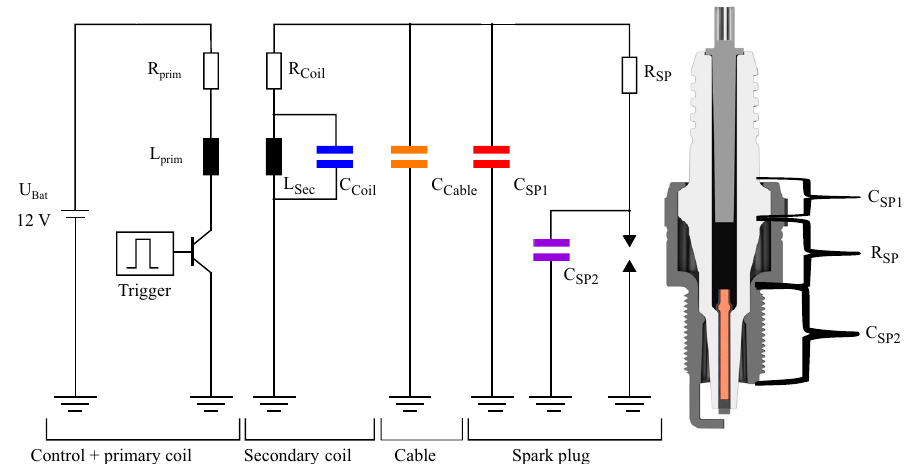
Fig. 1 Electric circuit of the ignition system used. The spark plug includes two capacitors with different time